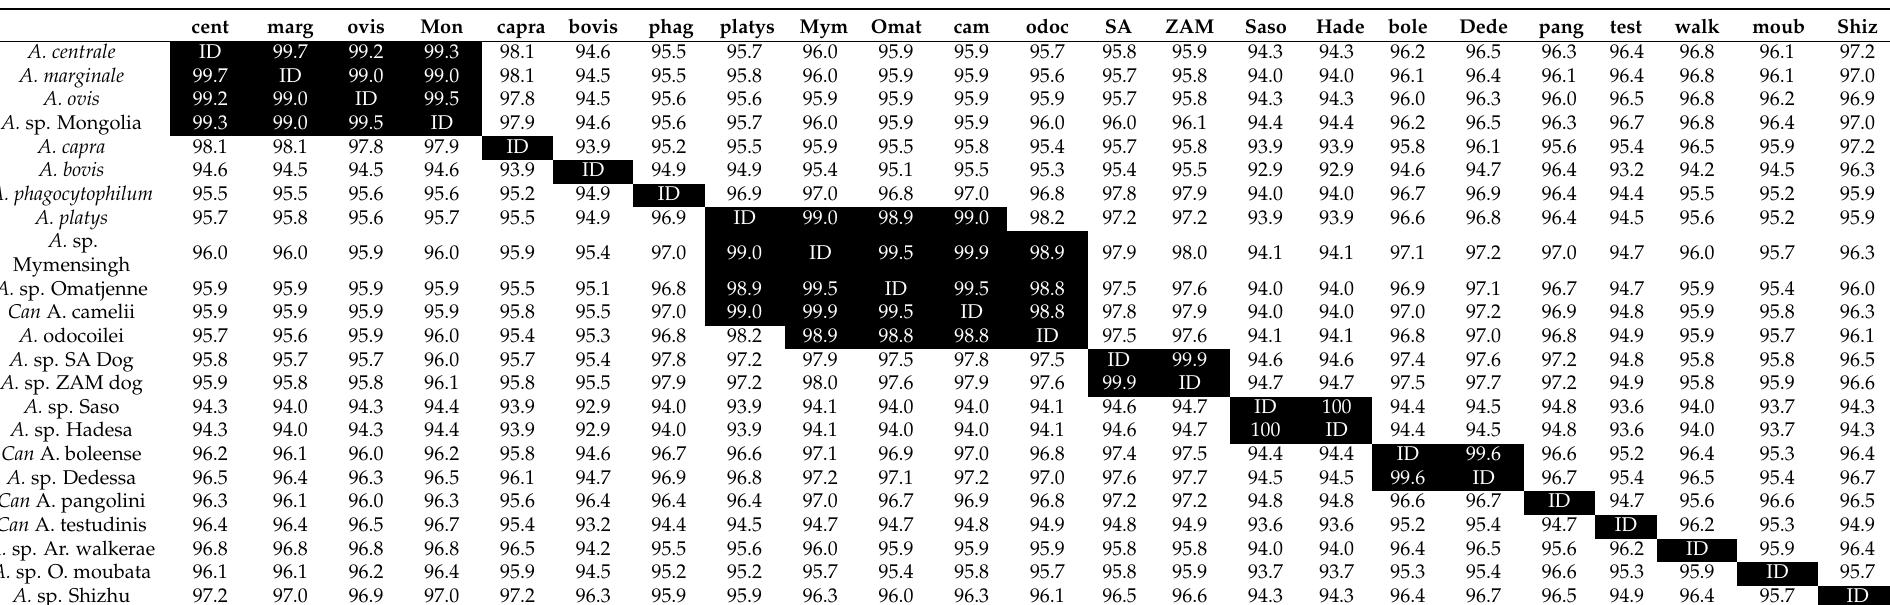
Table 3. Sequence identity matrix for 16S rRNA gene “consensus” sequences for Anaplasma